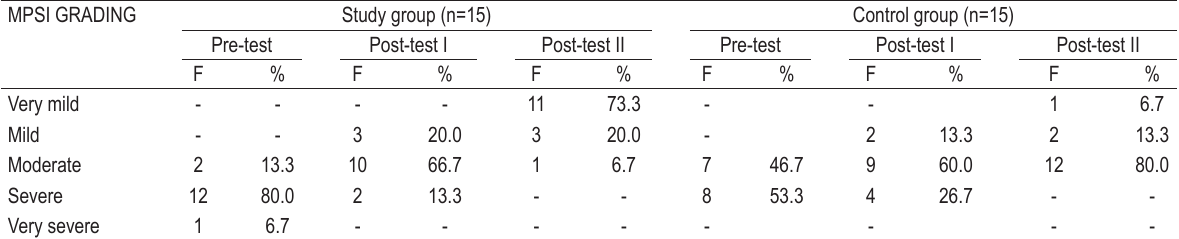
TABLE 3. Frequency and percentage distribution of psoriatic disease severity gradings based on modified psoriatic severity index (MPSI) score among study and control group (n=30)